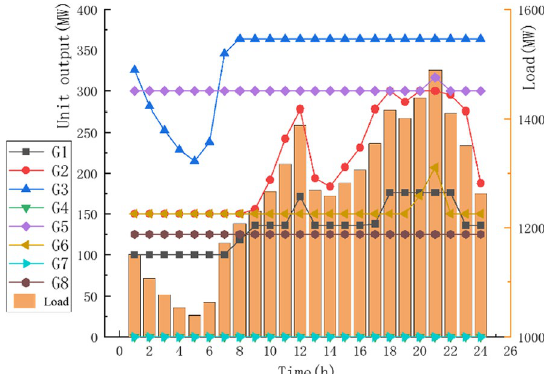
Fig. 10 Winning bids for units during re-adjustment market